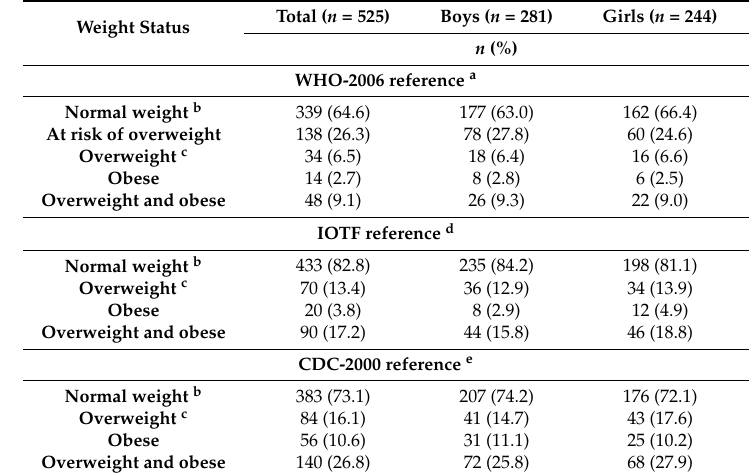
Table 1. Overweight/obesity prevalence among 2–5 years old Lebanese preschoolers, according to WHO-2006, IOTF and CDC-2000